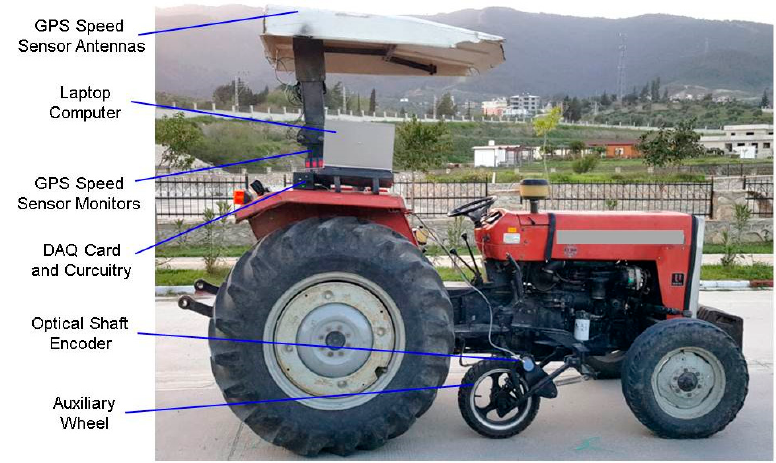
Figure 3. A view of the hardware mounted on the farm tractor.